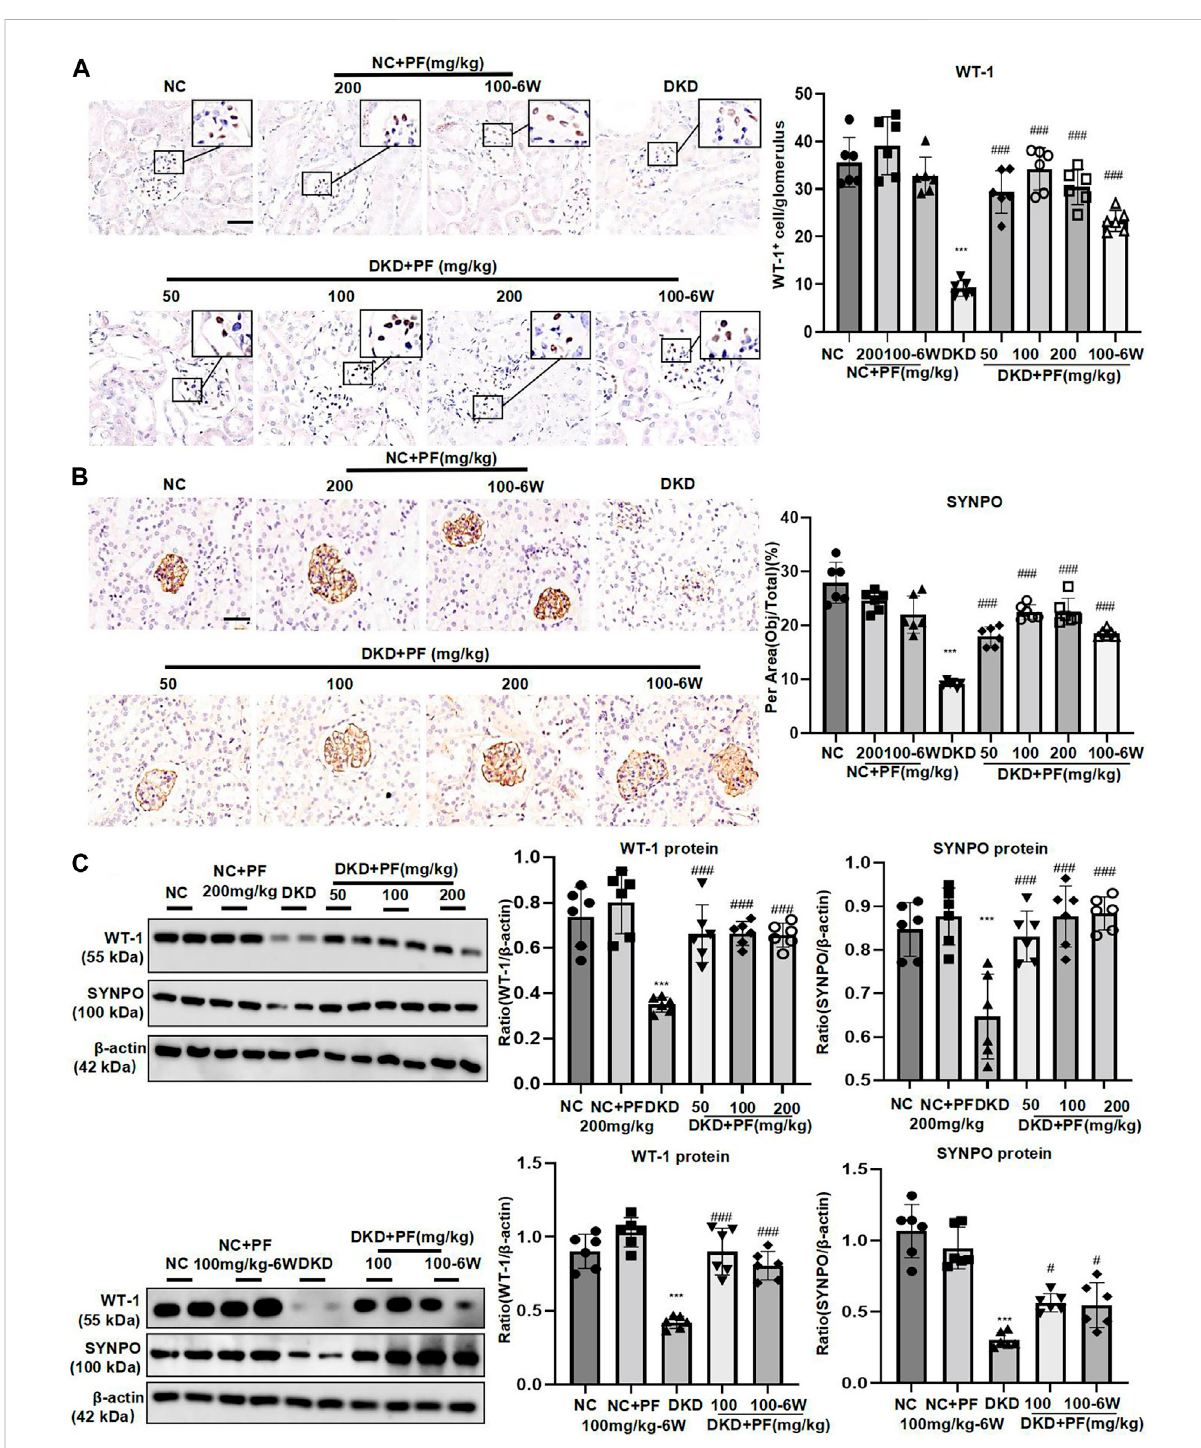
FIGURE 4 PFamelioratespodocyteinjuryinSTZ-induceddiabeticmice. (A) IHCassayofWT-1proteinexpressionintheglomerulus.Scalebar=50 μ m. (B) IHCassayofSYNPOproteinexpressionintheglomerulus.Scalebar=50 μ m. (C) WBassayofWT-1andSYNPOproteinexpressionintheglomerulus. Data represent the mean ± SD for 6 mouse/group. *** p < 0.001 vs. NC; # p < 0.05, ### p < 0.001 vs. DKD. NC, normal control; PF, paeoni fl orin; STZ, streptozotocin; DKD, diabetic kidney disease; WT-1, Wilms tumor 1 protein; SYNPO, synaptopodin; IHC, immunohistochemistry; WB, Western